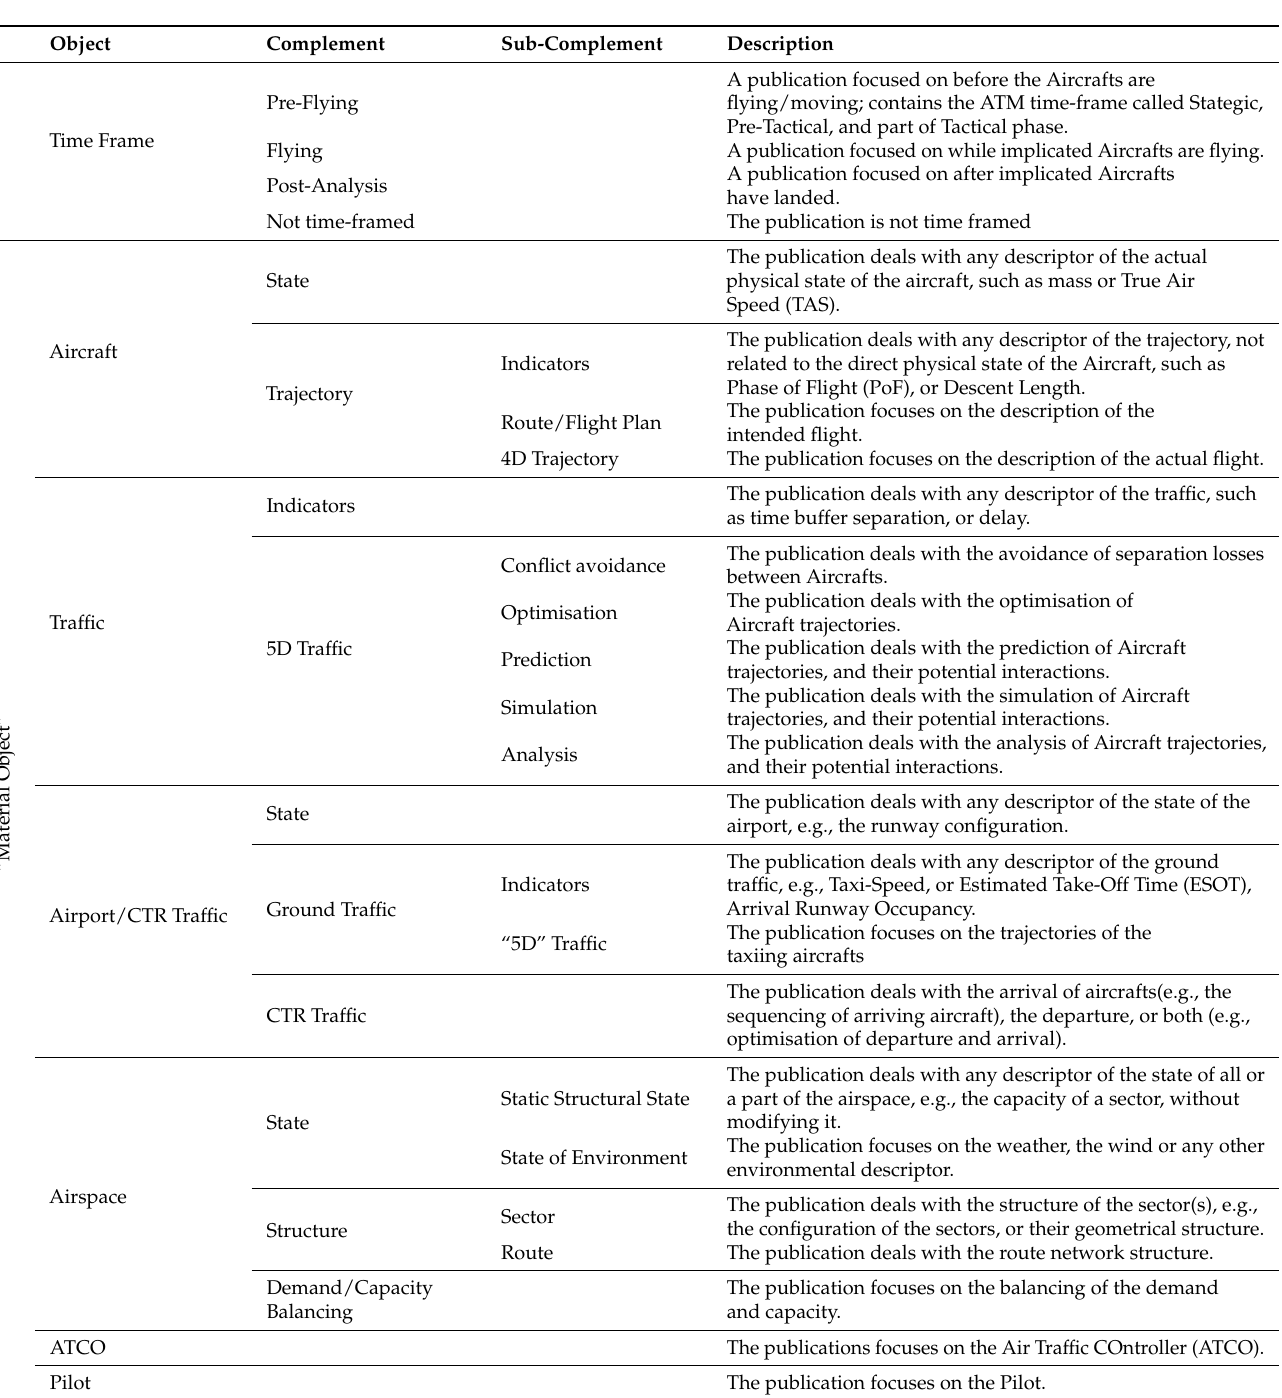
Table 4. Additional extracted